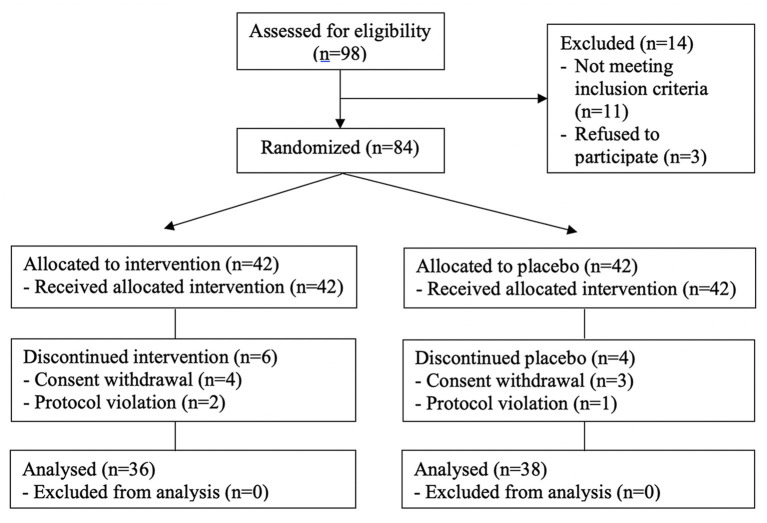
CONSORT flow diagram.